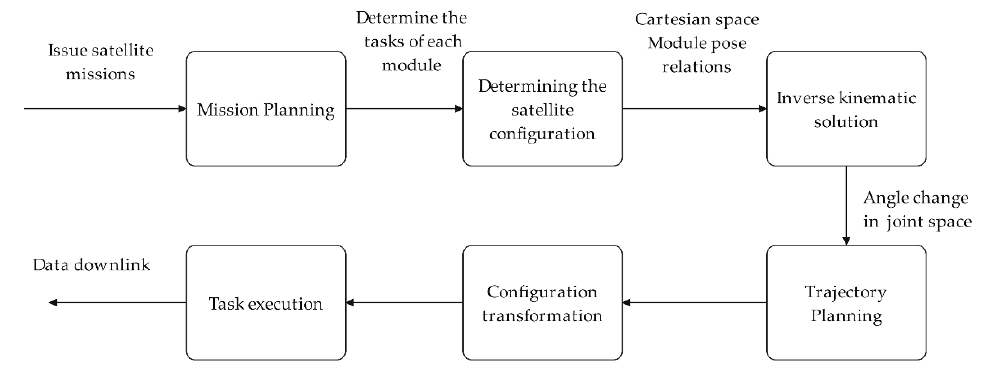
Figure 2. Modular self-reconfigurable satellite mission flow.